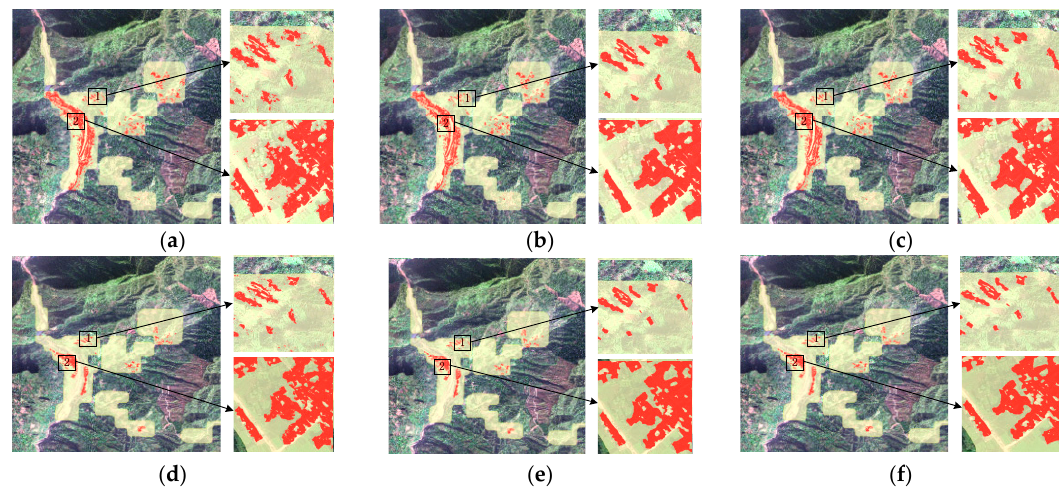
Figure 17. Building results of the MBI-based methods using the Pléiades image: ( a ) K means _MBI_Pix;